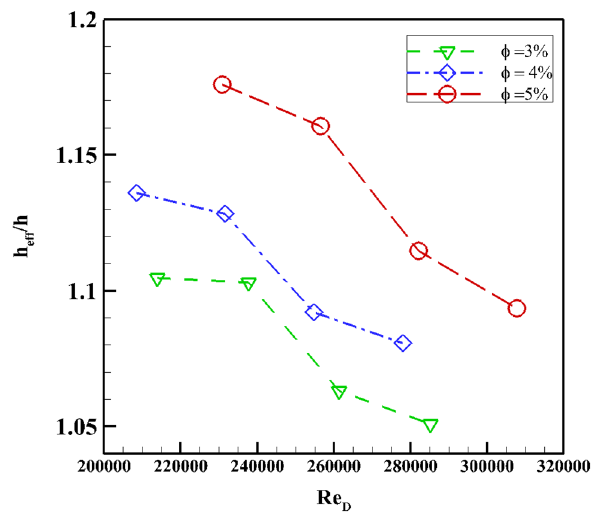
Fig. 27 Maximum temperature on WCP hot-side at constant con- centration vs Re D